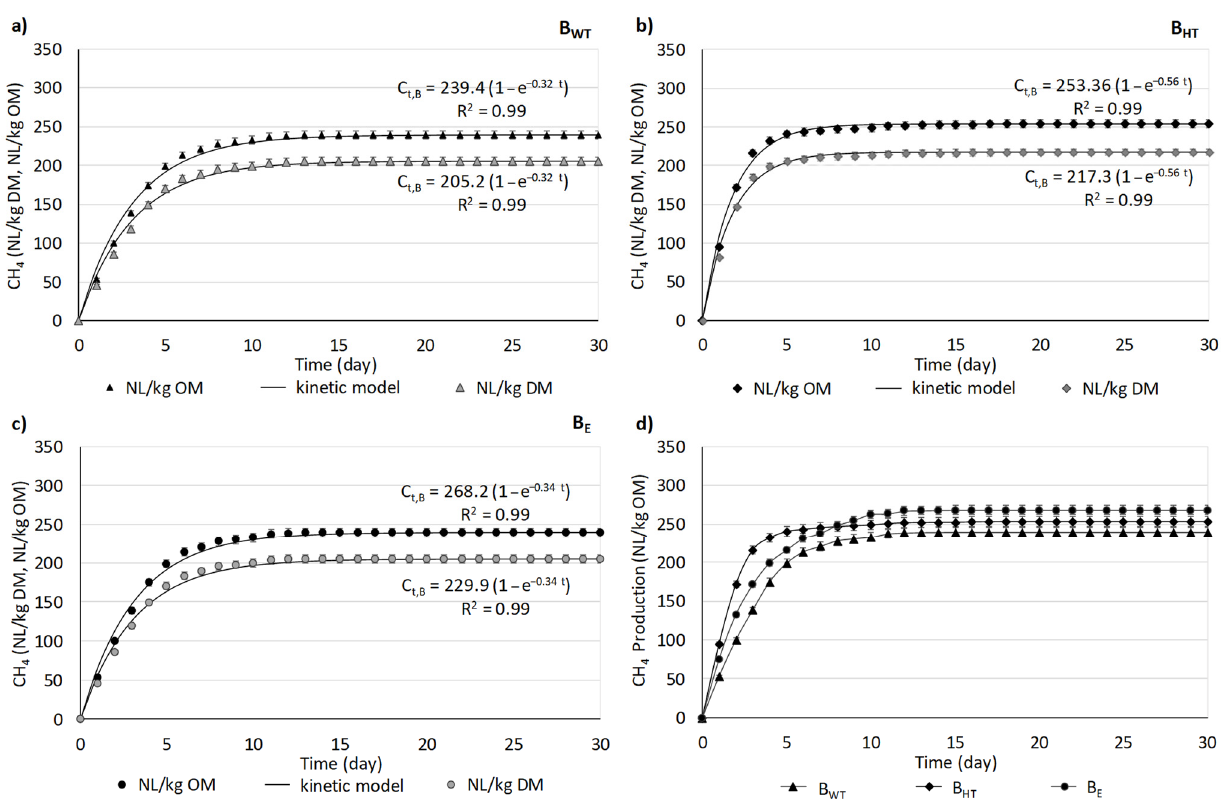
Figure 3. Changes in methane production during measurements. Pseudo-first-order kinetic models for methane production are provided ( a – c ); the average methane volume from B HT , B E , and B WT ( d